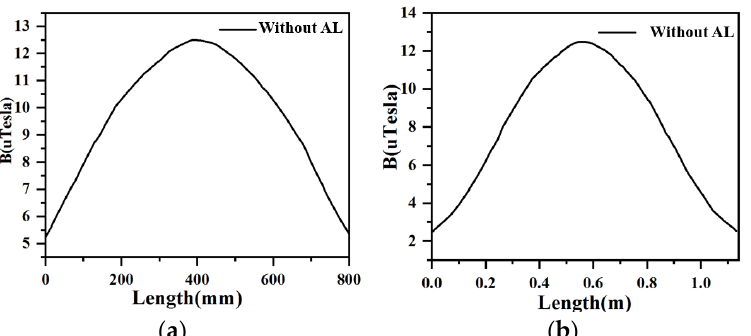
Figure 10. Magnetic induction intensity of shielding without aluminium plate: ( a ) transverse direc- tion; ( b ) diagonal direction.